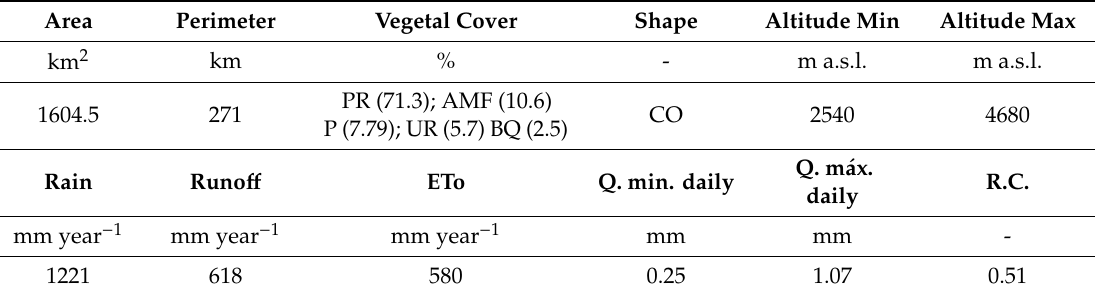
Table 1. Characteristics of the middle and upper parts of the Paute River basin.